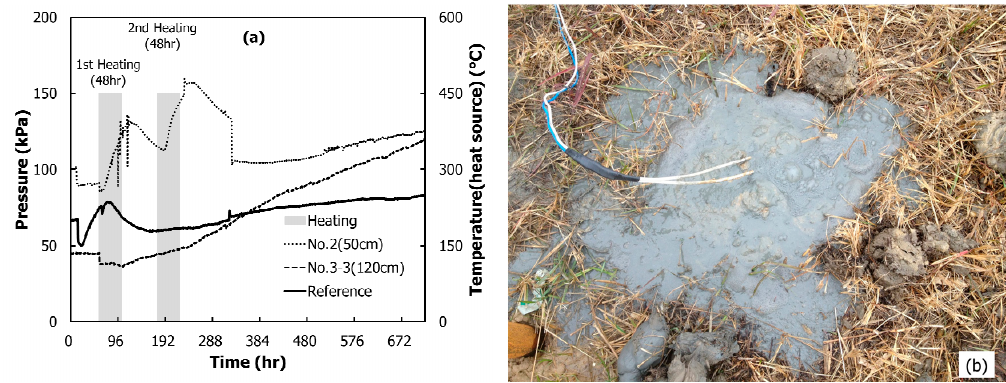
Figure 9. The variation of the vapor pressure by ground heating using an electric heat pipe. ( a ) The variation of the vapor pressure; ( b ) the bubbles on the ground surface.